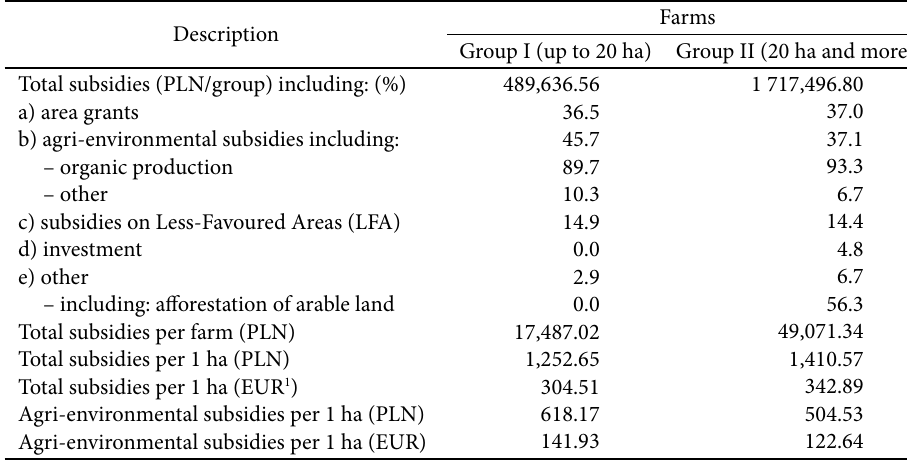
Table 3. Value and structure of subsidies in the years